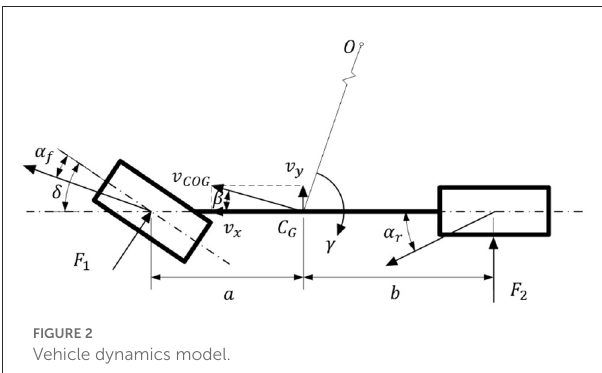
FIGURE2 Vehicle dynamics model.